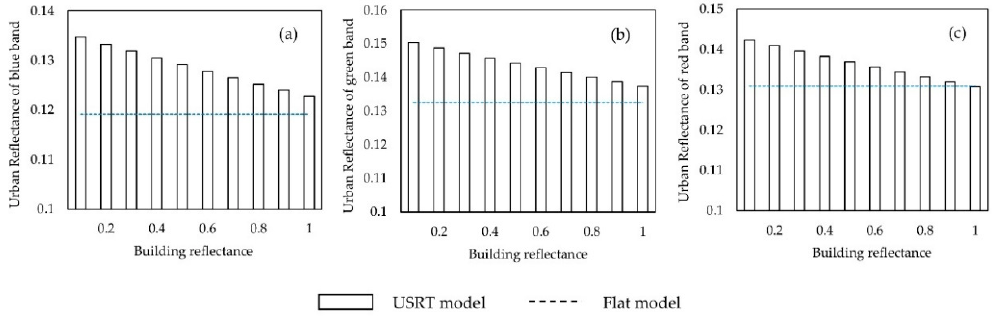
Figure 9. Reflectance comparison of the two models with different building reflectance. Note: ( a ) comparison of blue band reflectance from the two models; ( b ) comparison of green band reflectance from the two models; ( c ) comparison of red band reflectance from the two models.